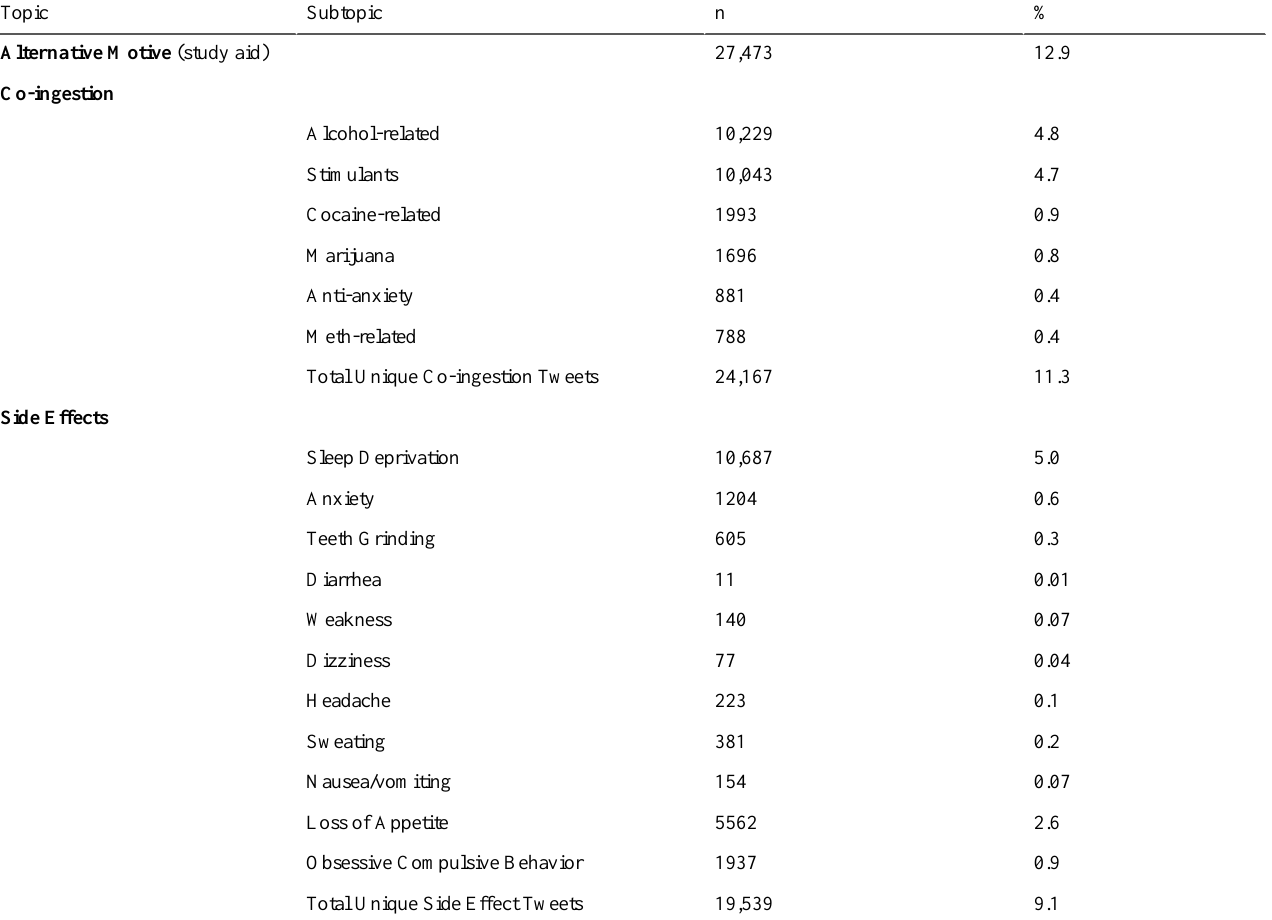
Table 2. Frequency distribution of Adderall tweets for search